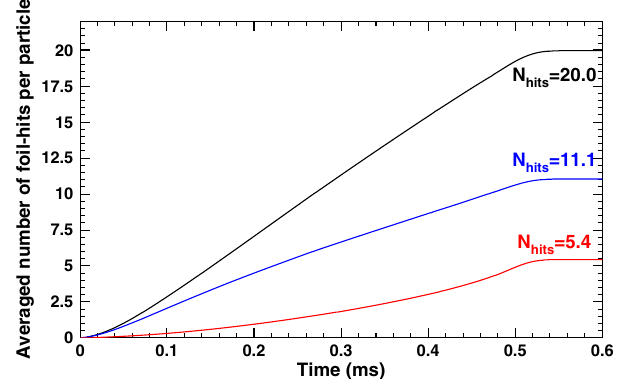
FIG. 38. Averaged number of foil-hits per particle during charge-exchange injection evaluated for correlated painting of ϵ 100 π mm mrad (black), correlated painting of ϵ tp ¼ 150 π mm mrad (blue), and anticorrelated painting of ϵ 200 π mm mrad